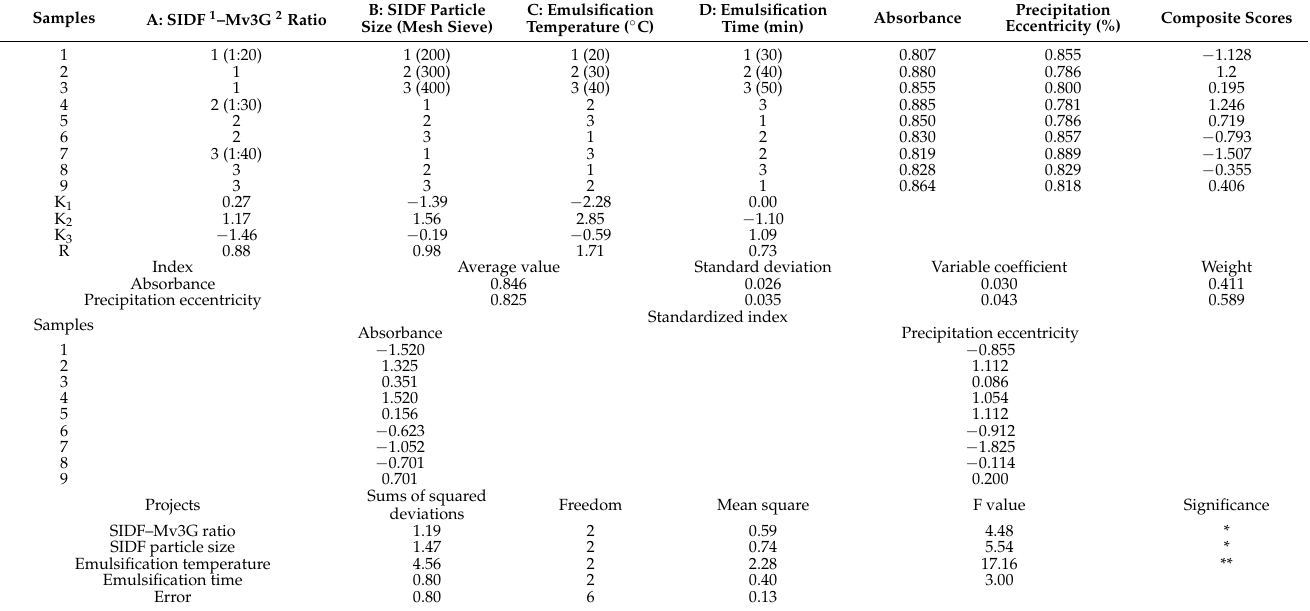
Table 1. Results of orthogonal